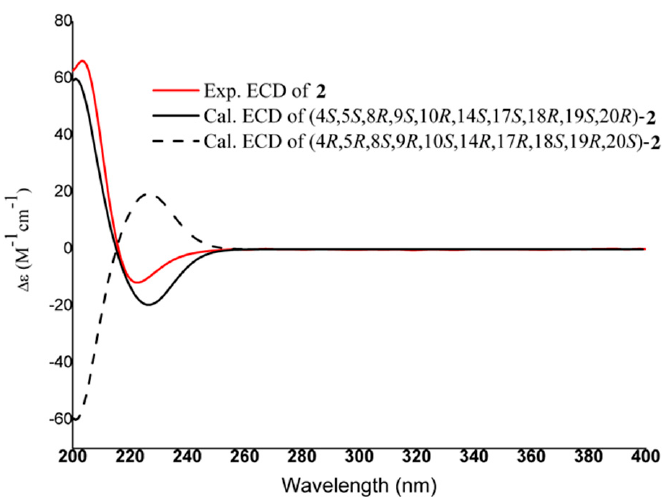
Figure 5. Experimental and calculated ECD spectra of 2.